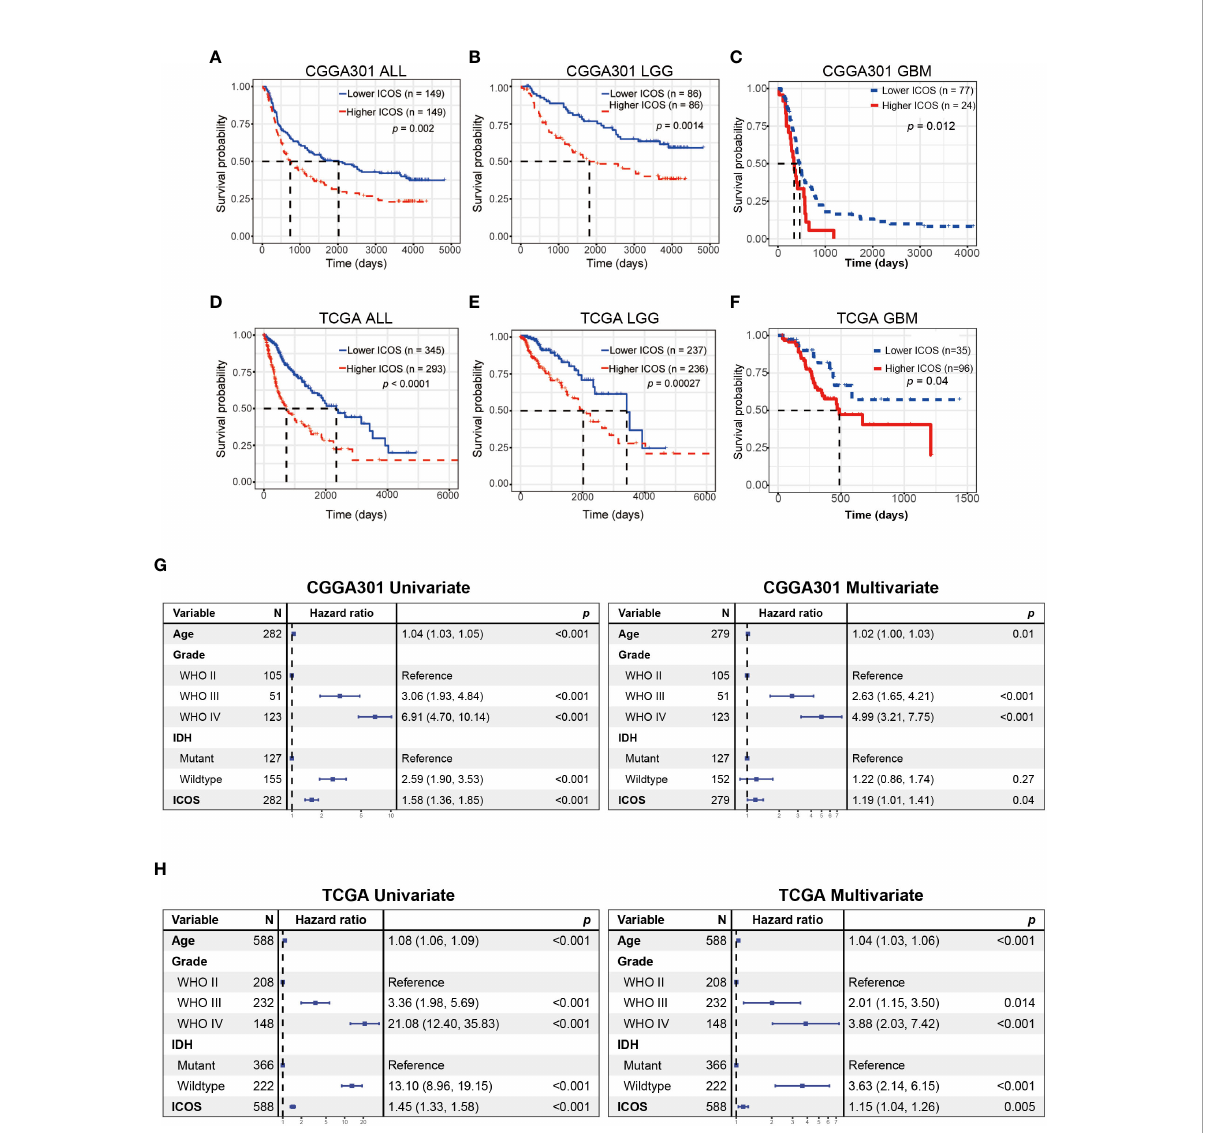
FIGURE 11 Survival analysis and Cox proportional hazards regression analysis according to ICOS expression. (A – C) Survival analysis in the CGGA301 dataset. (D – F) Survival analysis in the TCGA dataset. (G) Univariate and multivariate Cox regression model in the CGGA301 dataset. (H) Univariate and multivariate Cox regression model in the TCGA